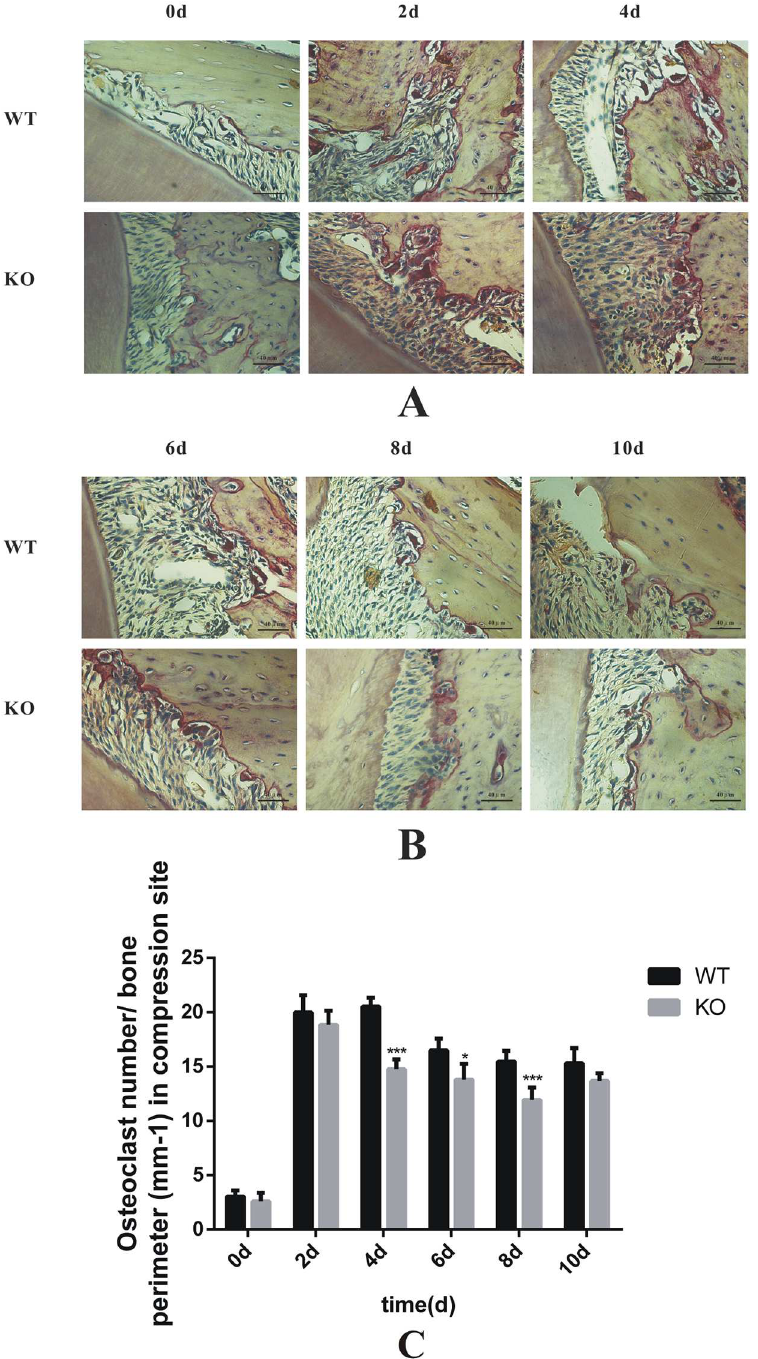
Fig 4. Osteoclastic activity was decreasedin the SOST deficient mice compared to the WT mice during tooth movement. (A) TRAP stainingat the compression sites in the WT and SOST KO mice at 0 d, 2 d and 4 d. (B) TRAP staining at the compressionsites in the WT and SOST KO mice at 6 d, 8 d and 10 d. (C) Quantification of the osteoclasts number per bonesurface (mm -1 ) at the compression site of mice tooth movement. The osteoclast number/bone perimeter increasedto the apex at day 4 and graduallydecreased through day 10 in the SOST KO mice and WT mice. The numberof osteoclastswas significantly lower in the SOST KO mice than in the WT mice at 4d, 6d, and 8d. * p < 0.05vs WT. *** p < 0.001vs